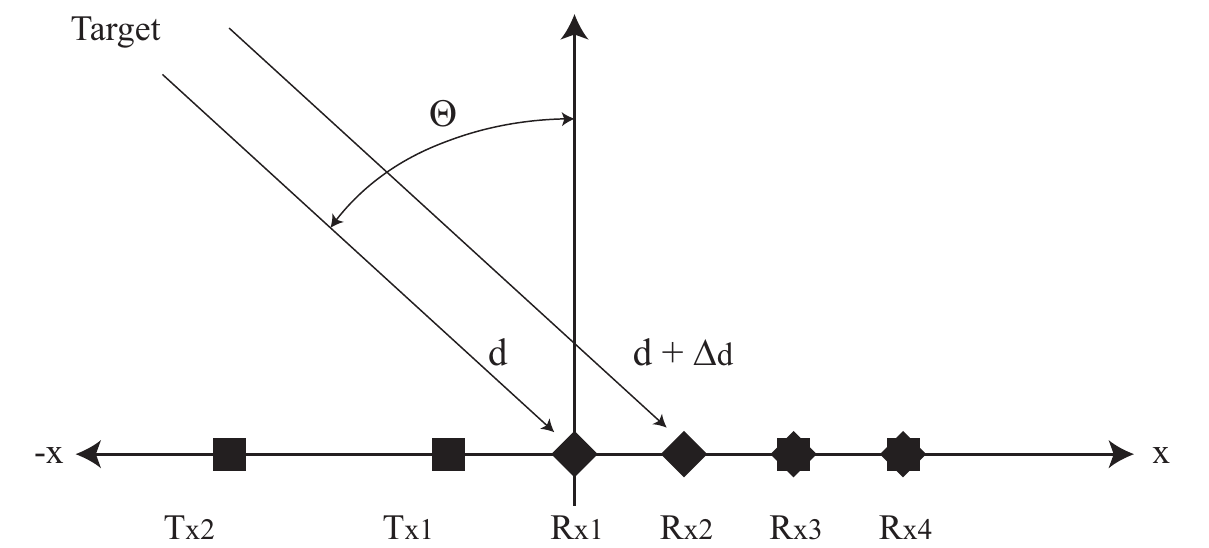
Figure 3. Generic MIMO antenna of an automotive Radar system. The squares are the transmitters, the rhombuses the receivers, and the stars the virtual elements of the